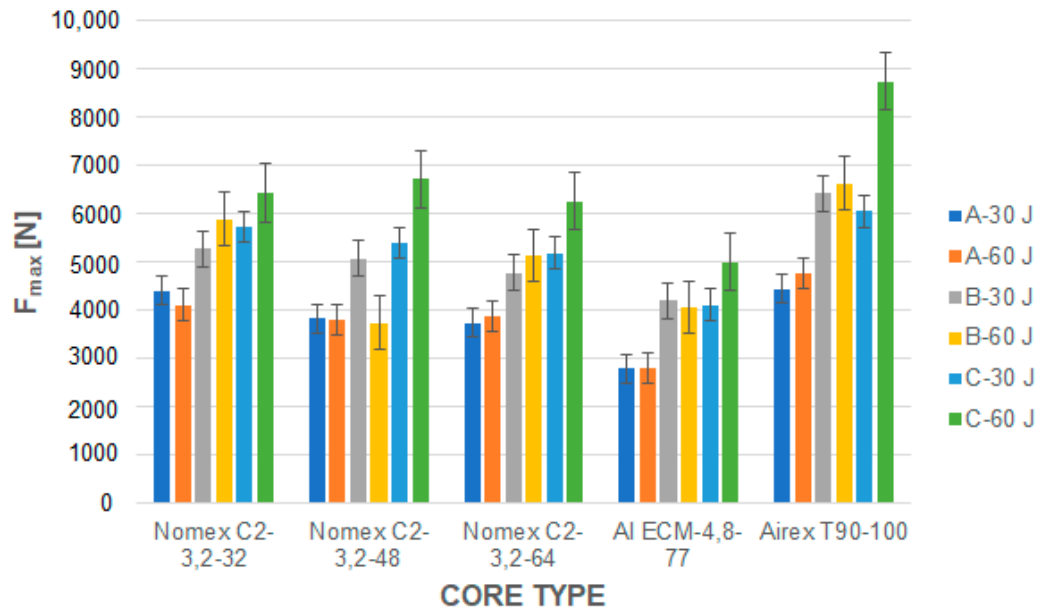
Figure 19. An overview of maximum forces in the impact tests. Sandwich constructions with cores of t c = 9 mm and t c = 10 mm thicknesses.